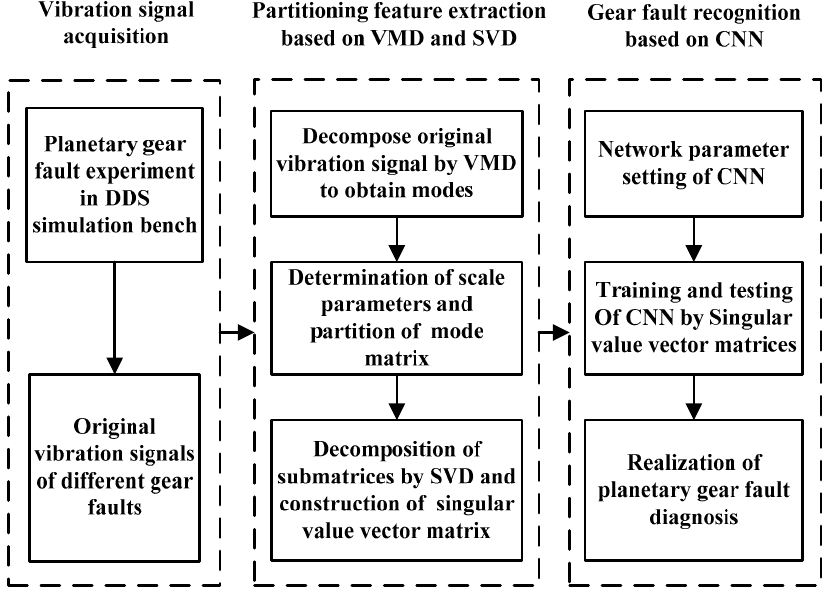
Figure 5. Experimental analysis flowchart.